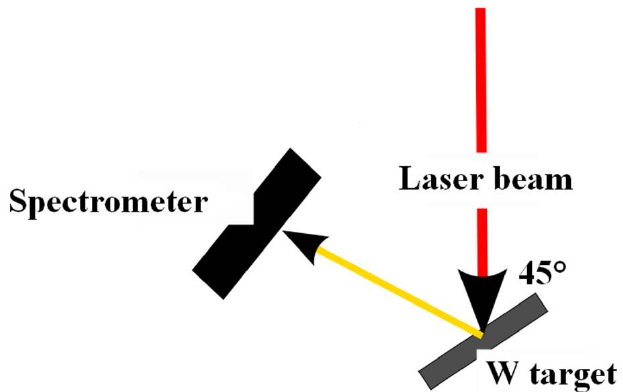
Figure 4. Experimental set-up: the laser beam is focused on the target with an incidence angle of 45 ◦ . The spectrum from plasma induced by laser pulse is recorded through a spectrometer.